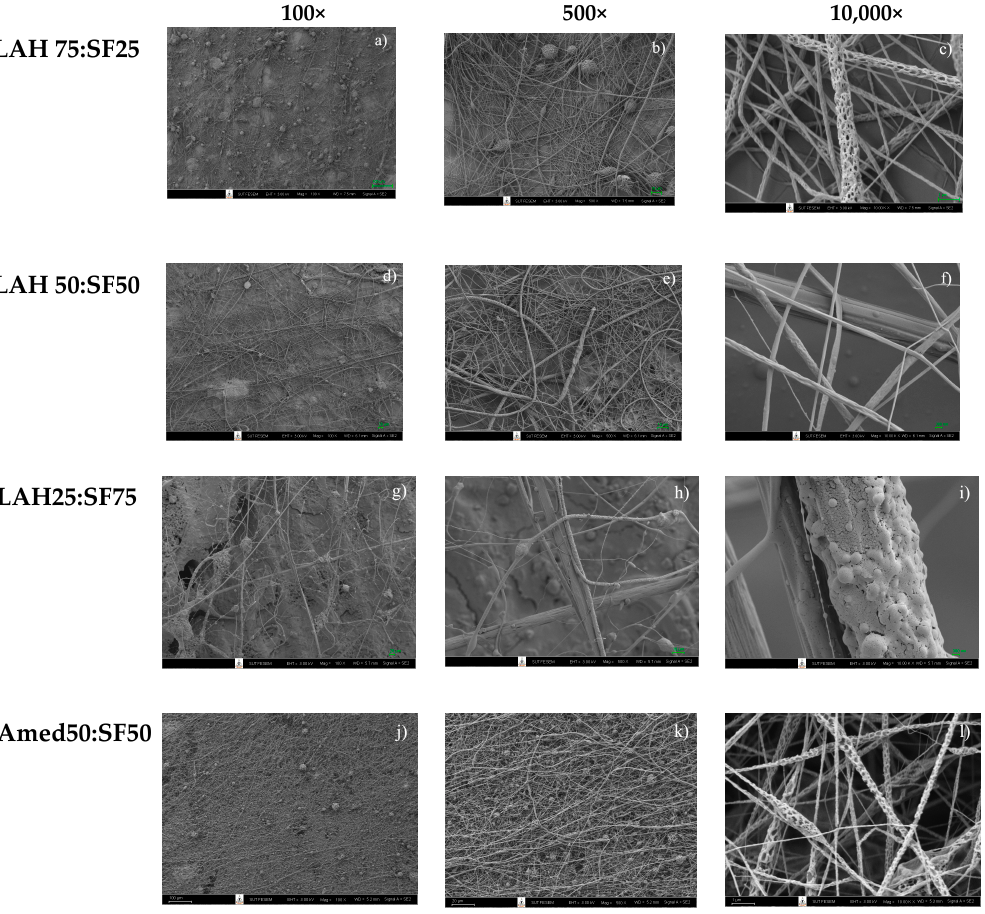
Figure 3. The morphology of ( a – c ) PLAH75:SF25; ( d – f ) PLAH50:SF50; ( g – i ) PLAH50:SF50; and ( j – l ) PLAmed50:SF50 fibers at different magnifications (100×, 500×, and 10,000×).